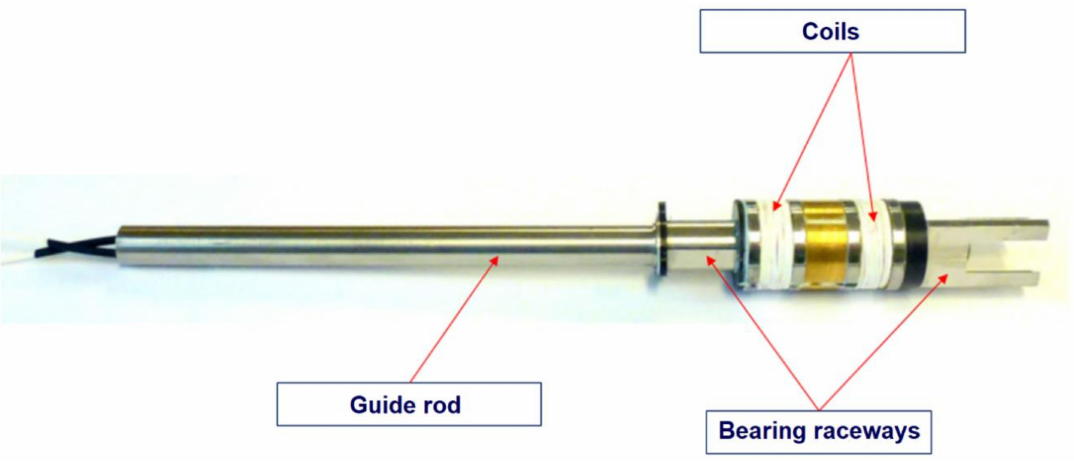
Figure 14. The counter-mass